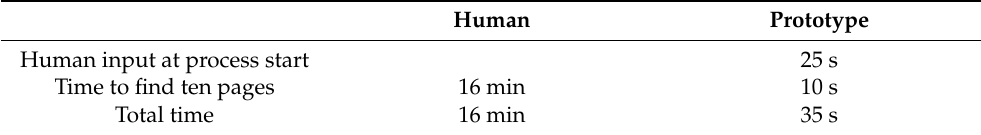
Table 5. Results of evaluation C regarding time